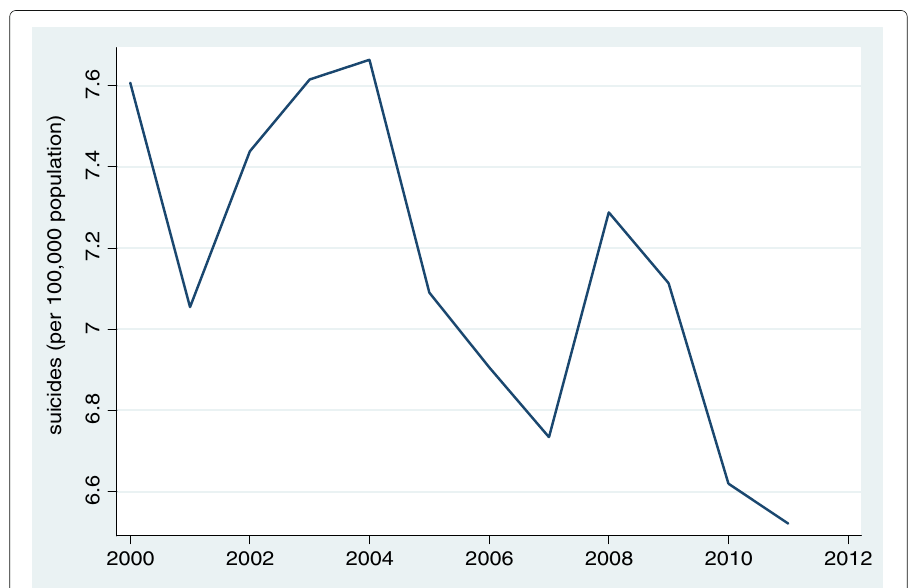
Fig. 6 Number of suicides in Spain. Source: Spanish Statistical Office. Death